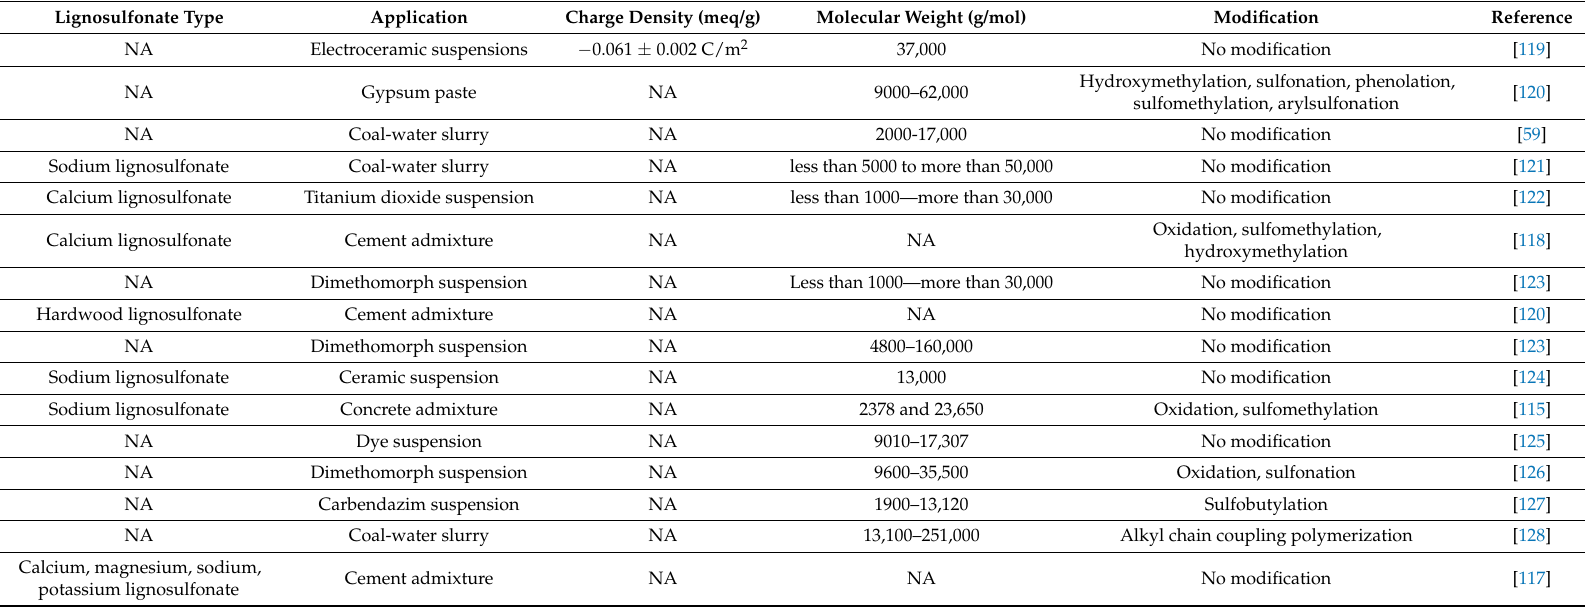
Table 7. Lignosulfonates as dispersants in various